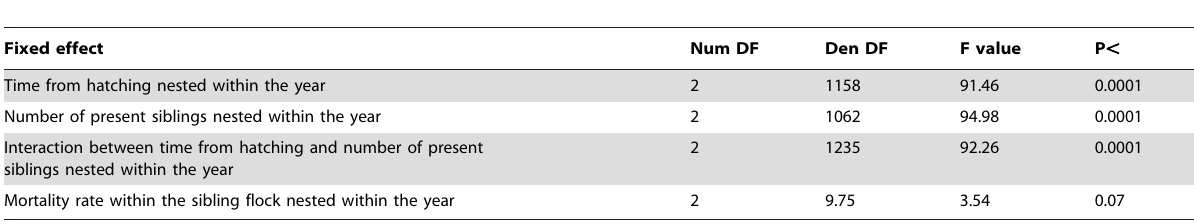
Table 2. The results of the GLMM for the Distance from the nest